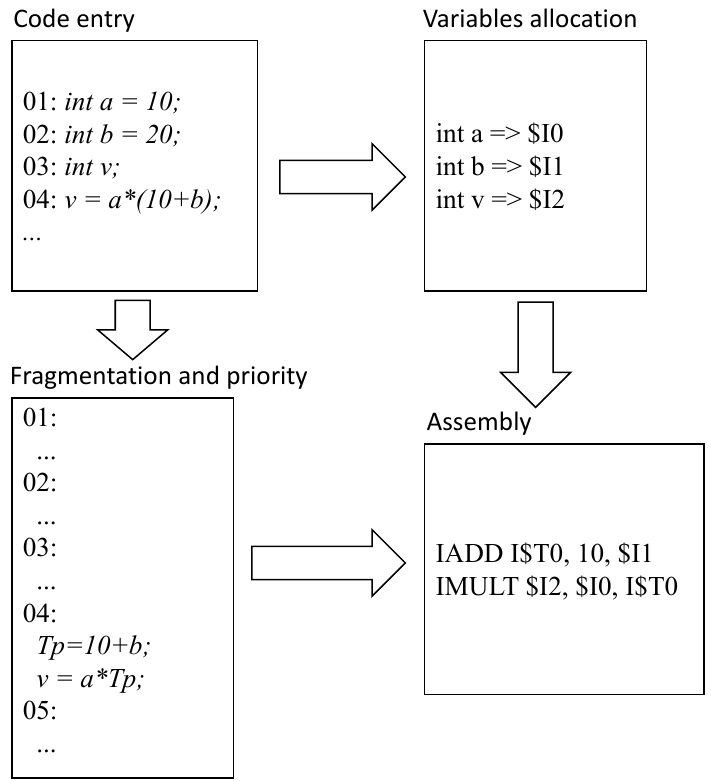
Figure 16. Compilation flow of an input code performed by